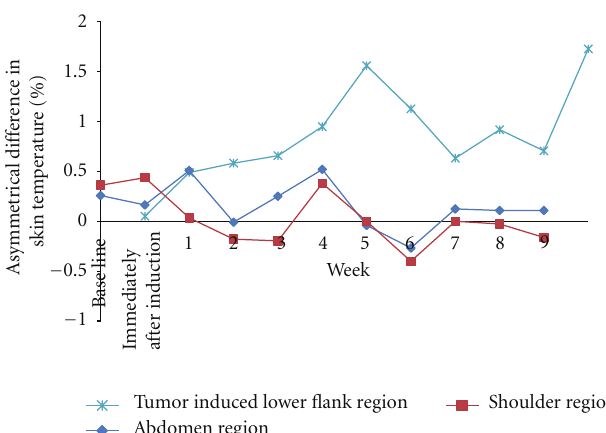
Figure 2: Percentage asymmetrical di ff erence in skin temperature comparison between lower flank (tumor induced region), abdomen, and shoulder regions. The value of asymmetrical di ff erence in skin temperature between left and right side ranges from 0.5 to 2.0% in the tumor induced flank region, whereas in the nontumor site (abdomen and shoulder regions) it was less than